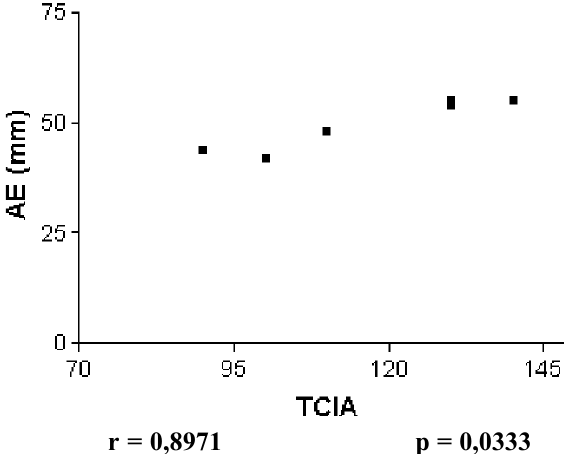
Figura 3 - Relação entre o tempo (em milissegundos) de condução interatrial (TCIA) e o diâmetro (em mm) do átrio esquerdo (AE) mensurado pelo